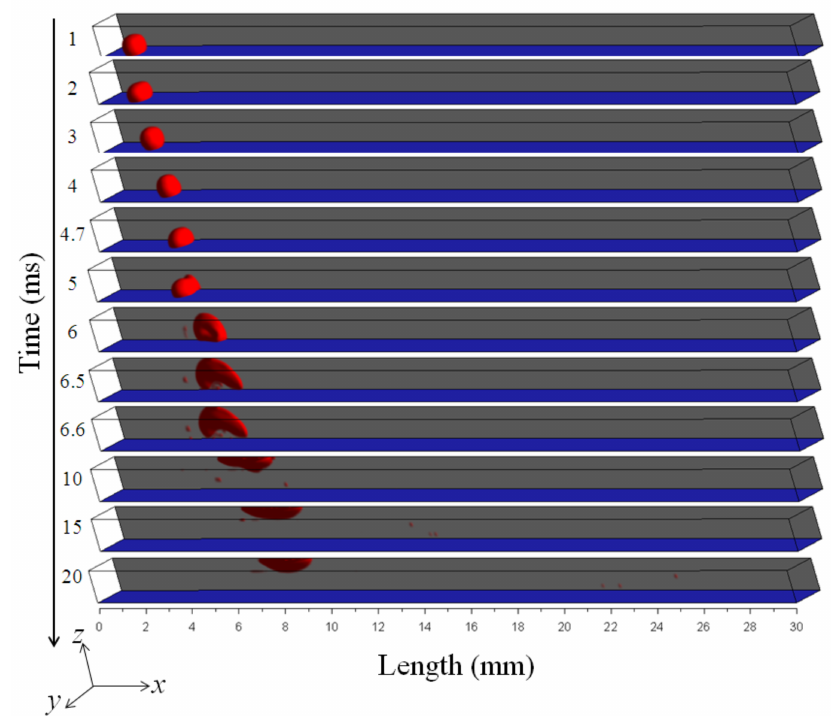
Figure 9. Water transport and dynamics in the flow channel with the channel surface contact angle of 45 ◦ , corresponding to Case 4 given in Table